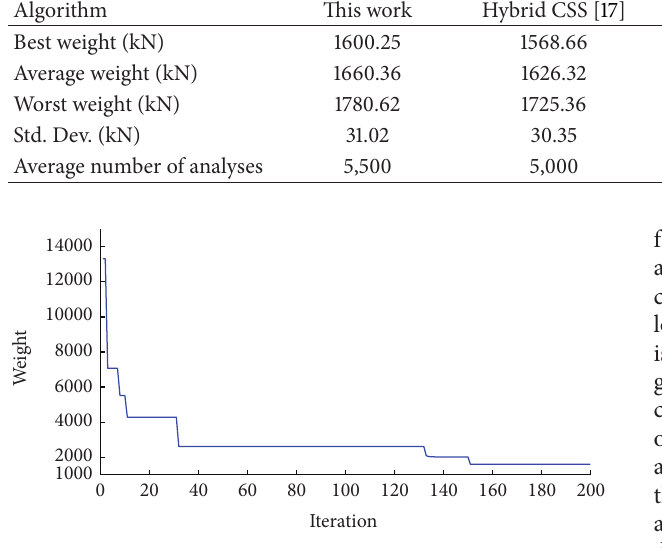
Figure 4: Convergence history of the CBO algorithm for the 4-bay 9-story